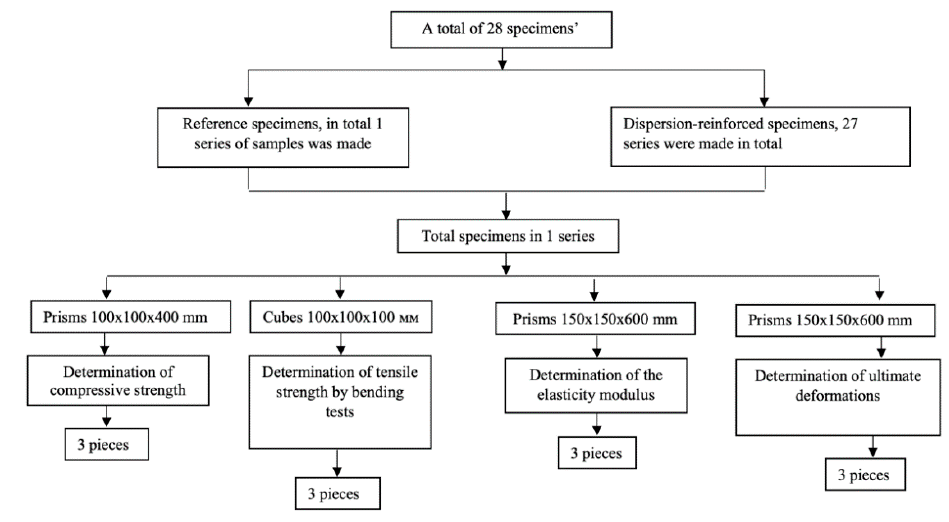
Figure 1. Block diagram of the experiment program.